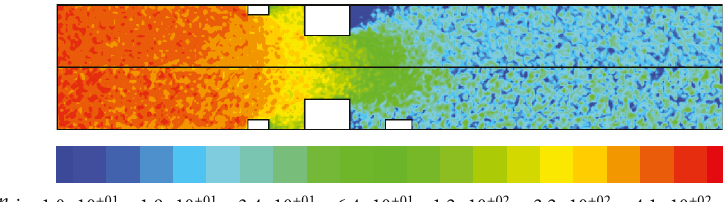
Figure 7: Number density distribution of neutral